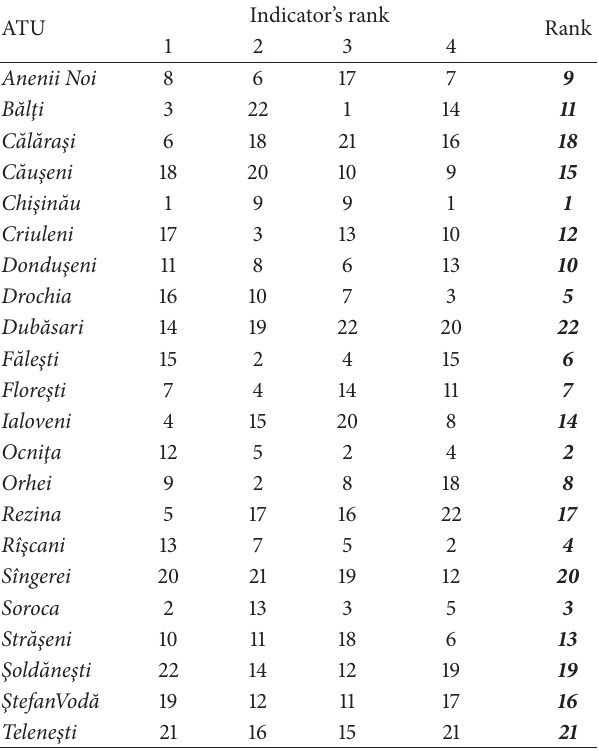
Table 5: Ranks of Moldova’s administrative-territorial units in the decreasing order of their adaptive capacity. ATU